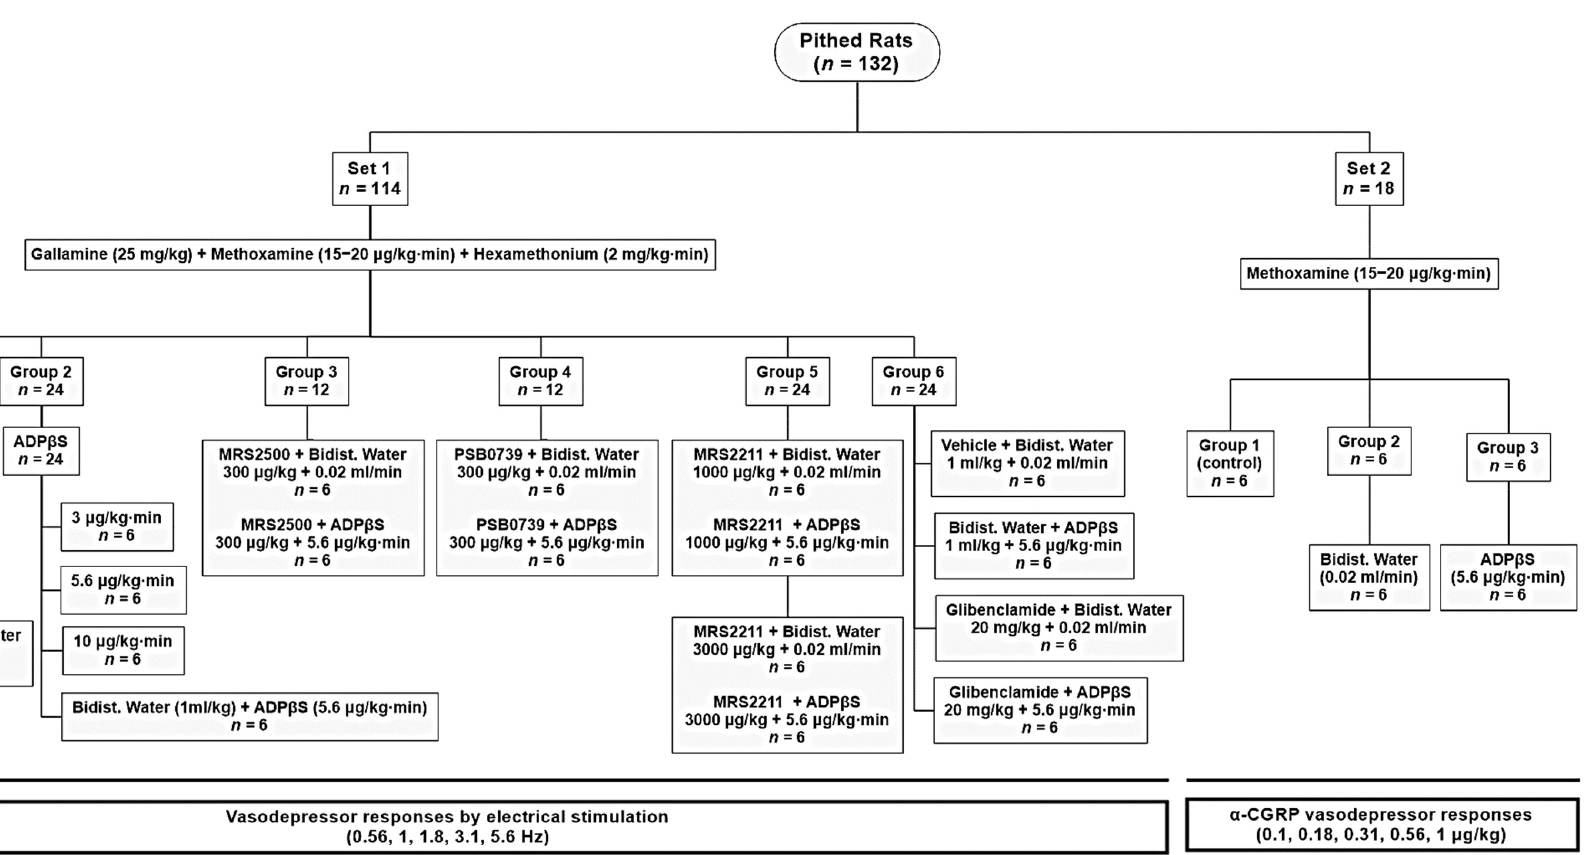
Figure 6. Experimental Design. Experimental protocols showing the number of pithed rats used in the two main sets and their subsequent division into different groups and subgroups.